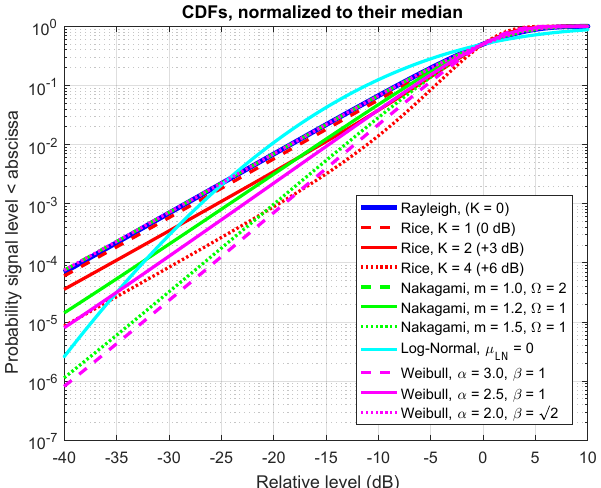
Figure 7. CDFs for Rayleigh, Rician, Nakagami and log-normal fading with different parameters. Where applicable, the parameter σ was chosen equal to